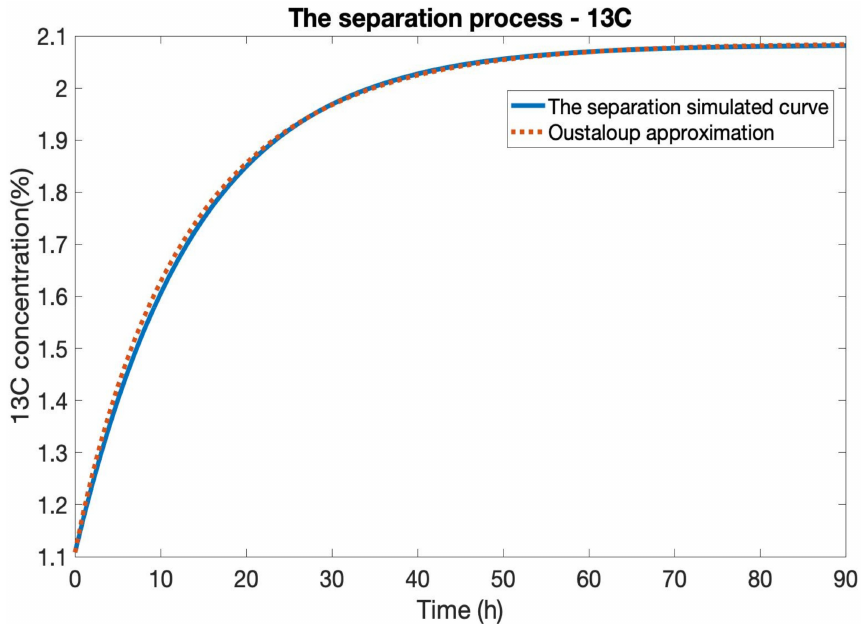
Figure 5. The most probable experimental curve dynamics and the response of the applied Oustaloup